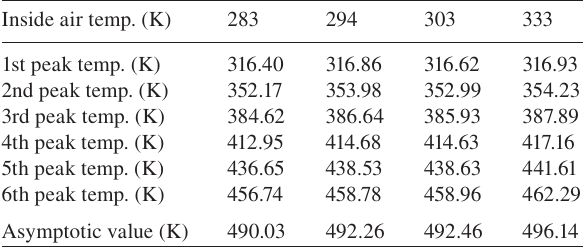
Table 3 Air temperature inside mandrel vs. peak temperature.